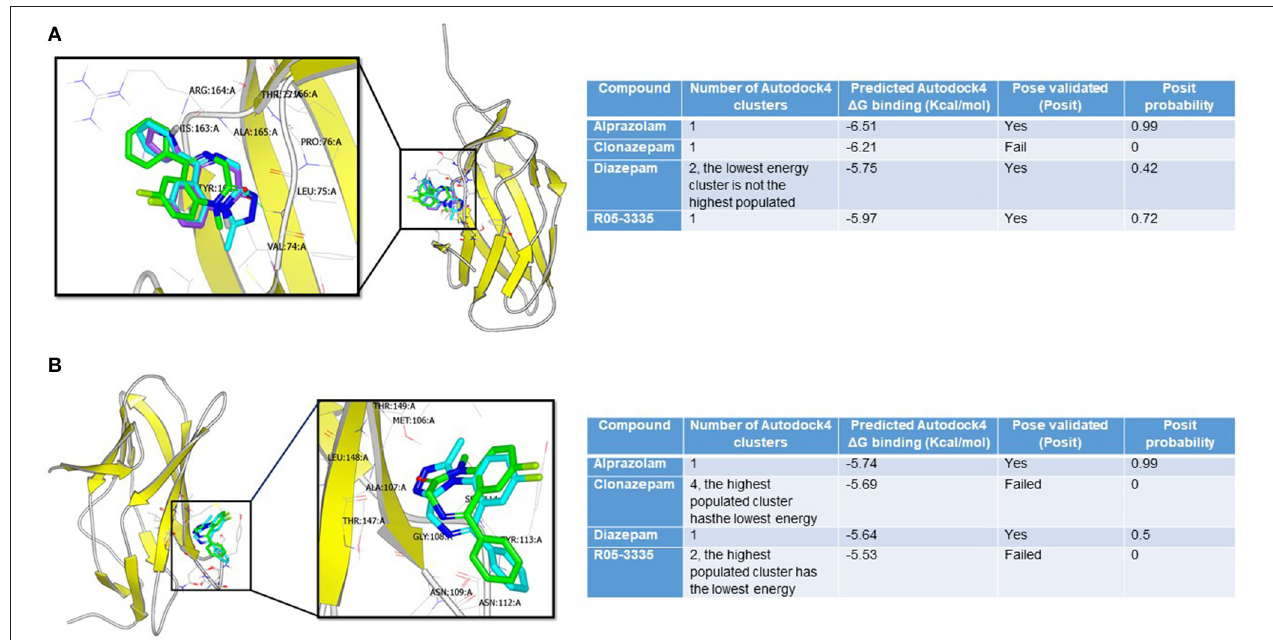
FIGURE 1 | Binding modes of benzodiazepines to RUNX1. (A) Alprazolam (cyan), diazepam (green), and R05-355 (purple) were predicted to bind at the bound pocket. Alprazolam has the highest POSIT probability (0.99 vs. 0.42 for diazepam and 0.72 for R05-355). (B) Only alprazolam (cyan) and diazepam (green) were predicted to bind at the unbound-RUNX1 pocket. Alprazolam has the highest POSIT probability (0.99 for alprazolam vs. 0.5 for diazepam).